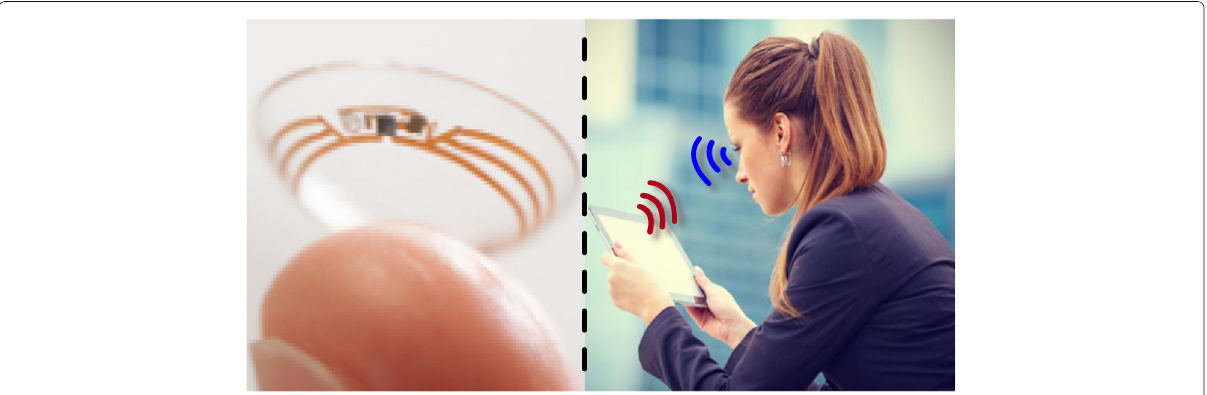
Fig. 13 BackCom application: smart contact